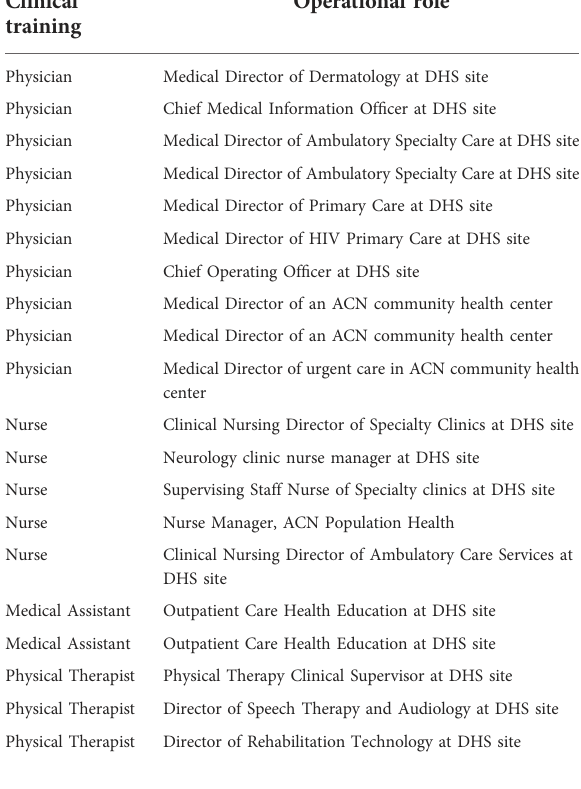
TABLE 1 Safety-net Stakeholders ’ clinical role/training and operational/leadership role relevant to telehealth implementation ( n